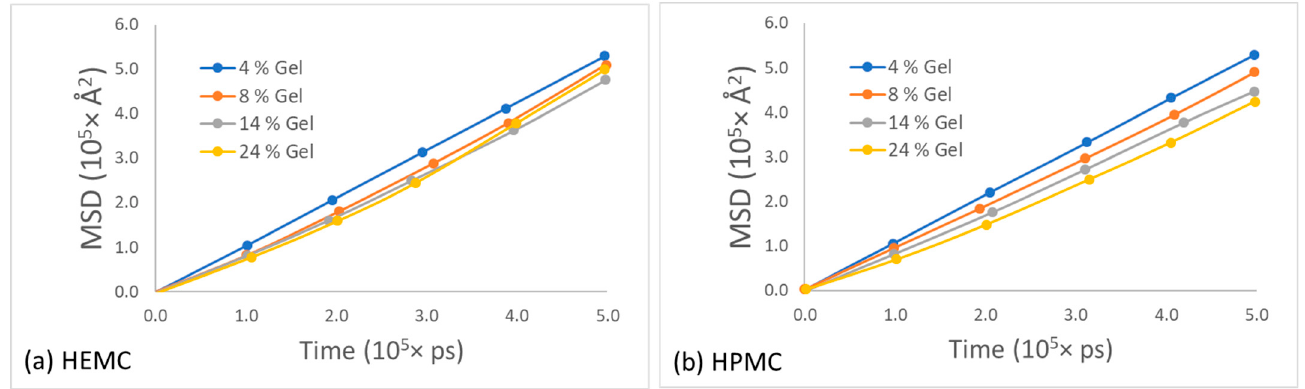
Figure 14. Mean square displacement of water for different polymer concentration gels for: ( a ) HEMC and ( b ) HPMC.